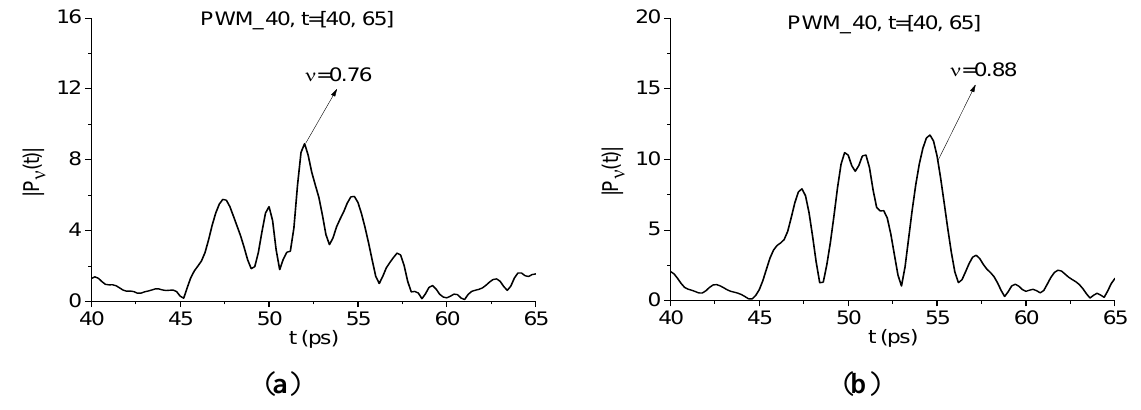
Figure 24. Dynamics of spectral lines of the PWM_1.5 signal at frequencies ν = 0.76 THz ( a ); ν = 0.88 THz ( b